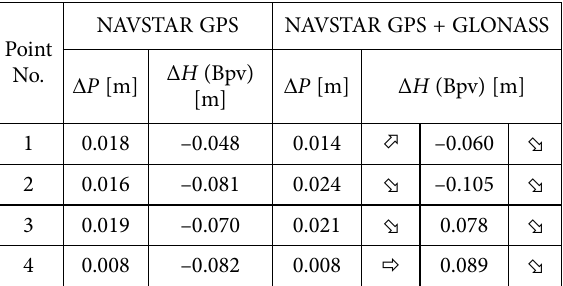
Table 5. Difference in the obtained accuracy (GPS vs. GPS + GLONASS) – 1st stage NAVSTAR Point No.